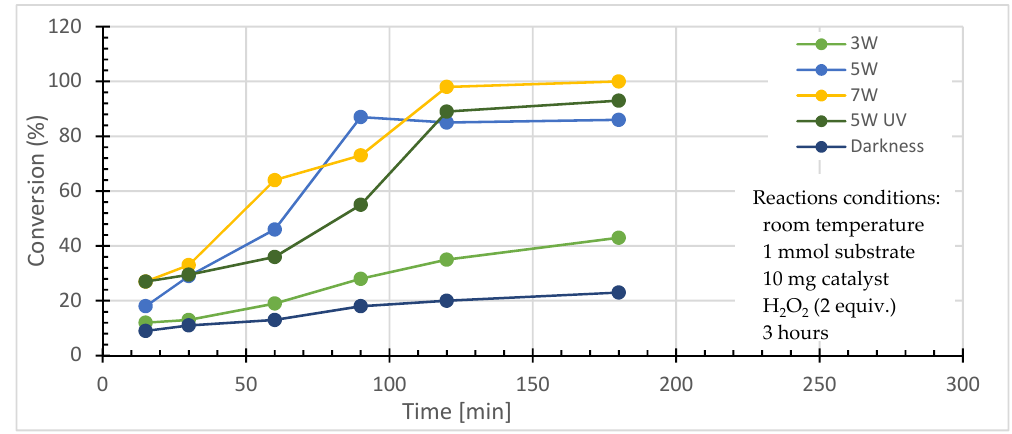
Figure 8. Optimization with respect to light intensity.